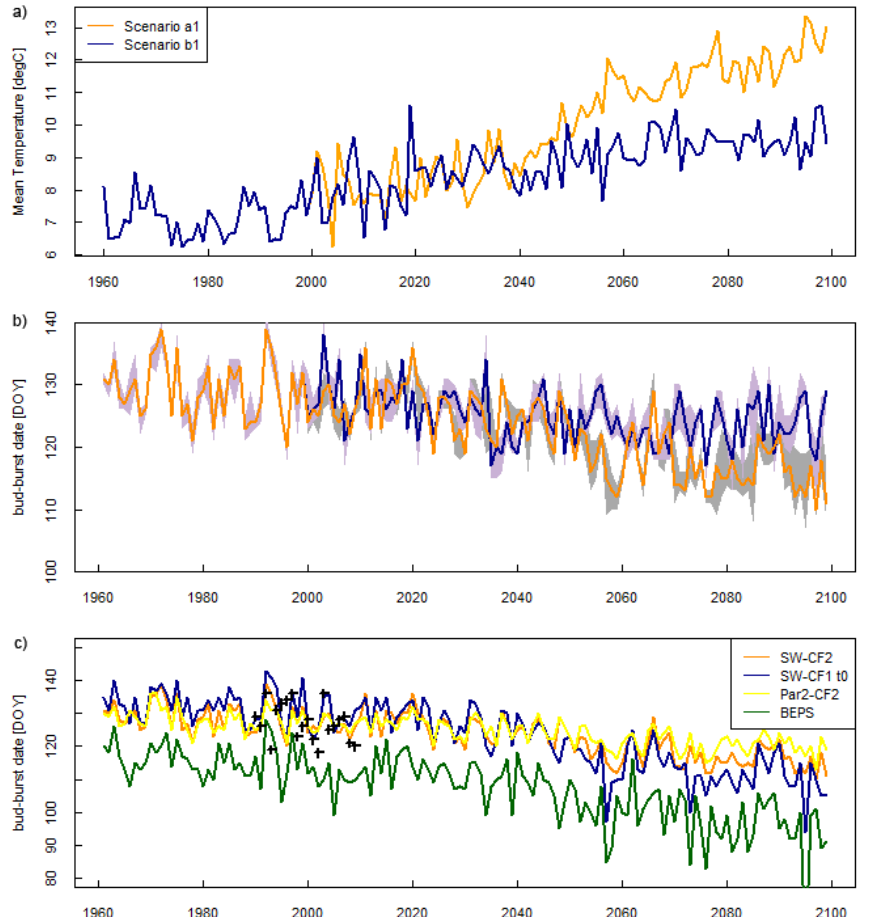
Fig. 3. (a) Time-series of mean annual temperature projections (1960–2099) under the scenario A1fi (orange line) and scenario B1 (blue line); (b) time series of bud-burst dates (BB) modeled for red oak (Quercus rubra) with the best model selected (Table 1). Blue line represents the BB projected under the scenario B1, orange line represents the BB projected under scenario A1fi. Gray area represents the uncertainty for the scenario A1fi, while light purple area represents the uncertainty for scenario B1; (c) time series of bud-burst date (BB) modeled for red oak with SW-CF2 (best model), SW-CF2t0 (as SW-CF2 but without photoperiod limitation), Par2-CF2 (second best model) and with the internal phenological routine in BEPS (green line). Gray crosses represent the phenological observations collected at Harvard Forest. Models in Fig. 2c are forced by temperatures from the scenario A1fi.